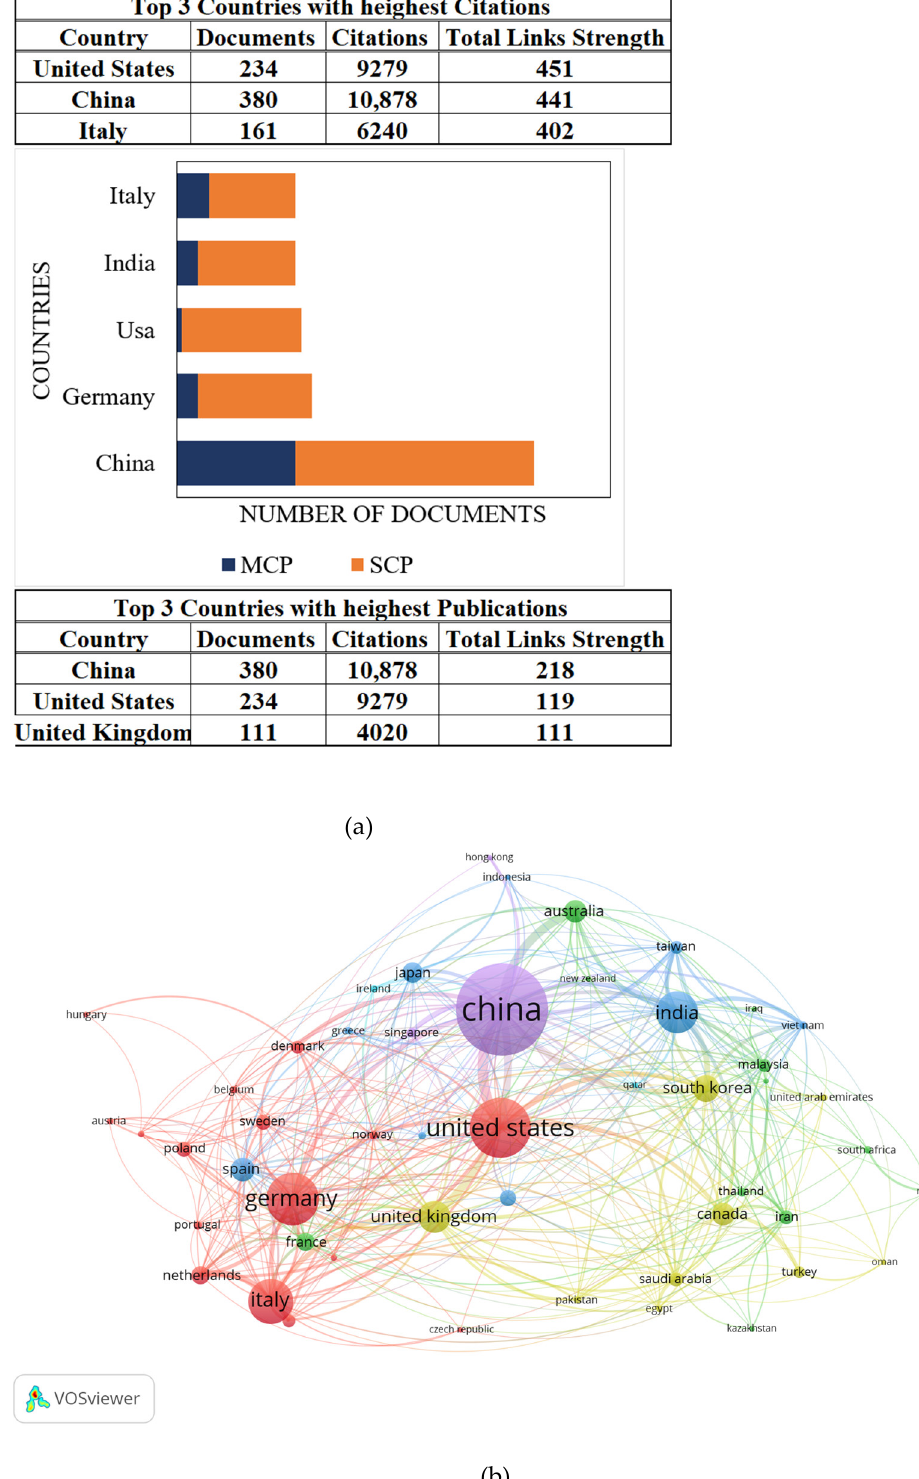
Figure 6. (a,b) Performance of countries. Figure 6. ( a , b ) Performance of